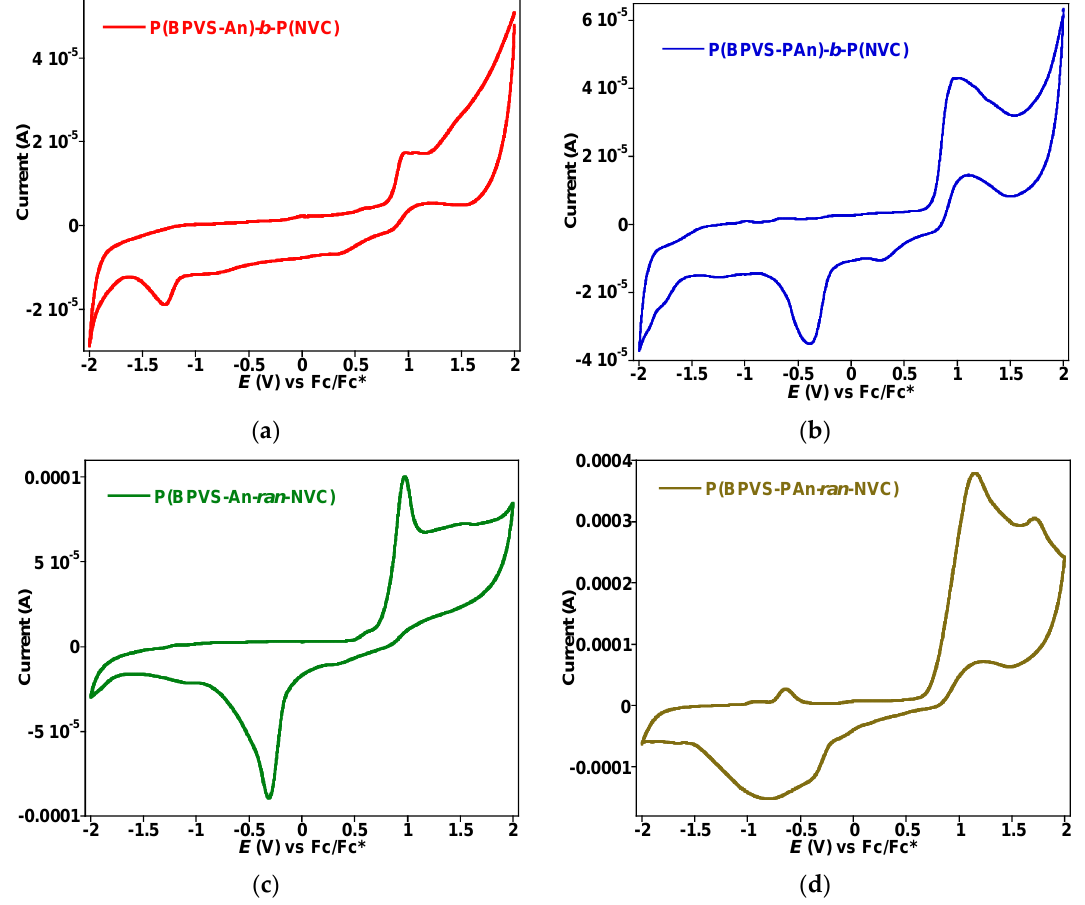
Figure 3. CV spectra of ( a ) poly(BPVS-An)- b -poly(NVC); ( b ) poly(BPVS-PAn)- b -poly(NVC); ( c ) poly(BPVS-An- ran -NVC); and ( d ) poly(BPVS-PAn- ran -NVC). Table 2. Electrochemical properties of polymers.